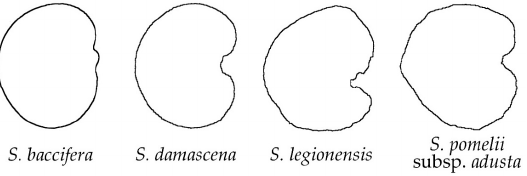
Figure 1. Silhouettes of the lateral views of seeds in the group of smooth outline.